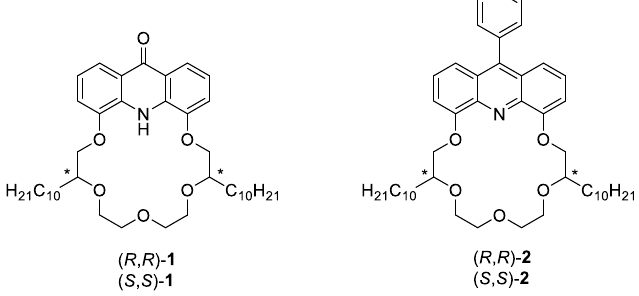
Figure 1. Schematics of new lipophilic enantiopure crown ethers.